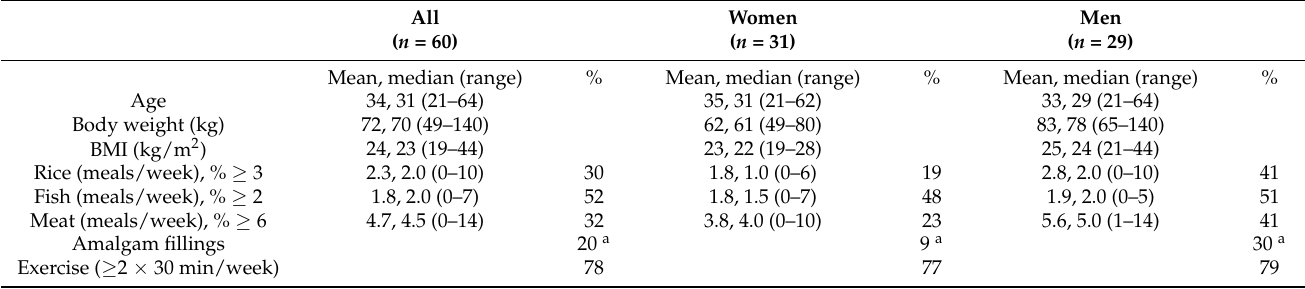
Table 1. Background factors in 60 subjects participating in the variability